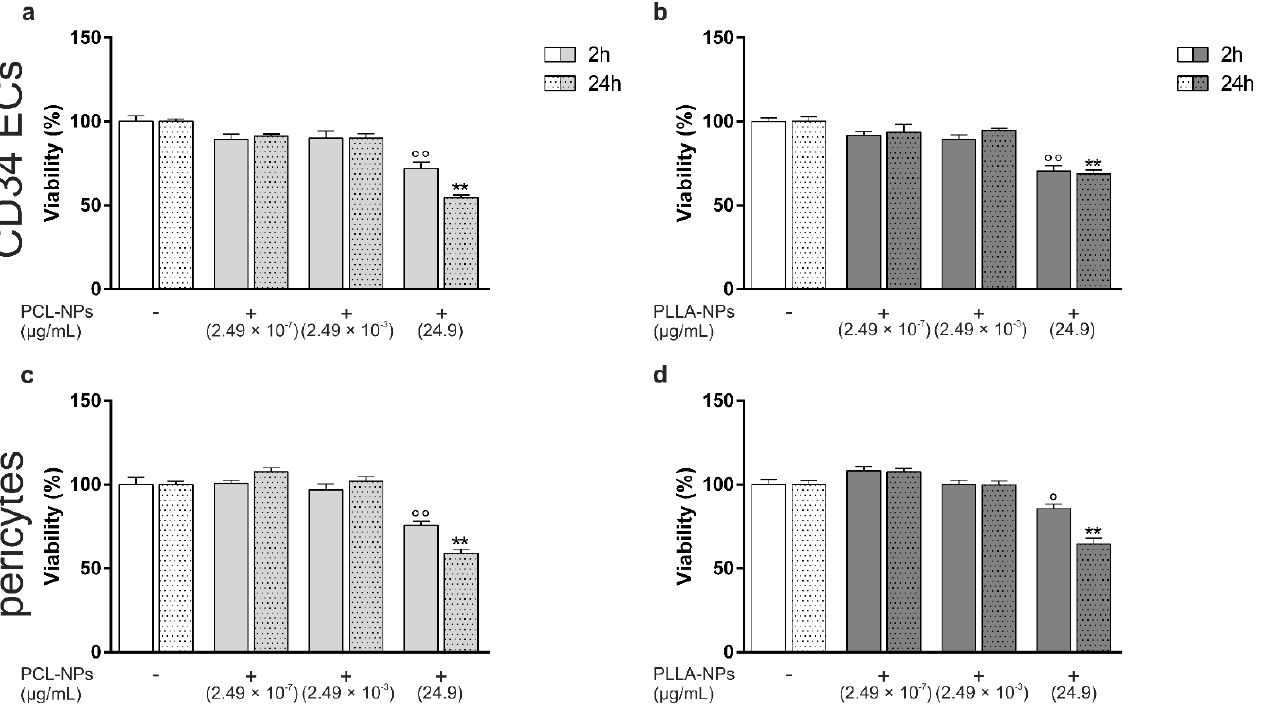
Figure 1. Concentration- and time-dependent effects of silica-ICG/poly( ε -caprolactone) (PCL)- ( a , c ) and silica-ICG/poly( ε -caprolactone-poly(L-lactide)) (PLLA)- ( b , d ) Nanoparticles (NPs) on the viability of CD34+ endothelial cells (ECs) ( a , b ) and pericytes ( c , d ). Both cell types were exposed to NPs for 2 (filled bars) and 24 h (dotted bars) at three different concentrations ( n = 3). Exposure to NPs is marked with a +, cells not exposed to NPs with a − . Error bars represent SEM. Significant differences between NP ‐ exposed and non ‐ exposed controls (white bars) are labeled with circles (°) for 2 h of NP exposure and with asterisks (*) for 24 h of NP exposure (° = p ≤ 0.05; °°/** = p ≤ 0.0001). Due to the slight decrease in cell viability, the medium concentration (2.49 × 10 − 3 as well as a potential cytotoxic effect on CD34+ ECs and pericytes. PCL ‐ NPs were used to